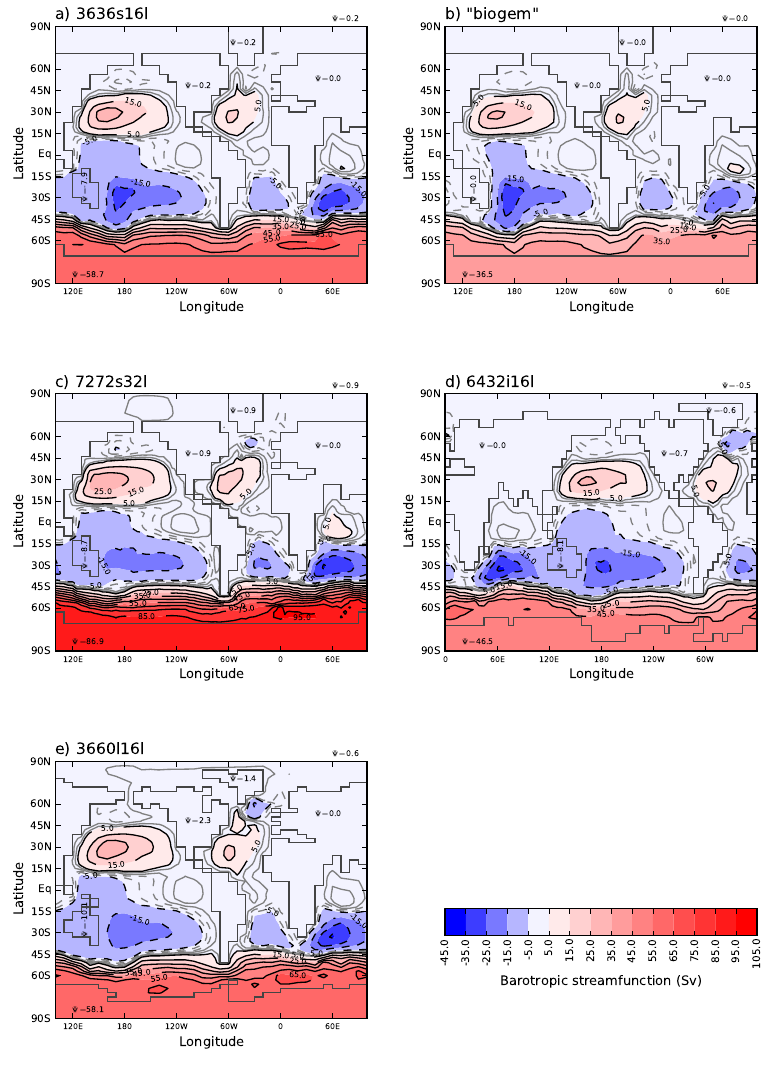
Fig. 19. Barotropic streamfunction (Sv) in the five experiments. Values for the streamfunction over disconnected land masses are included (over the respective land masses, and, for the barotropic flow around the North Pole, at the top left corner of the panels). The contour interval in the range from − 5Sv to 5Sv is 2Sv, and outside this range it is